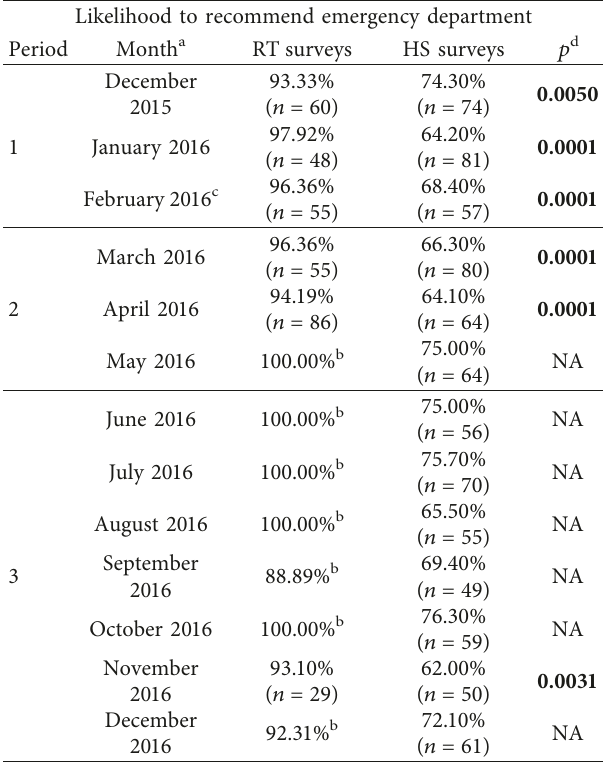
Table 2: Would you recommend this emergency department to your friends and family? Likelihood to recommend emergency